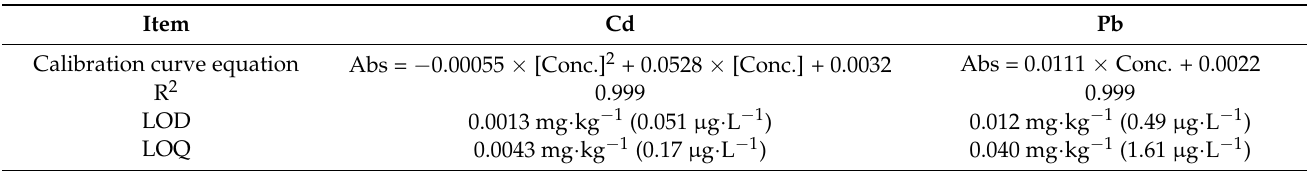
Table 6. Calibration and limit of detection and